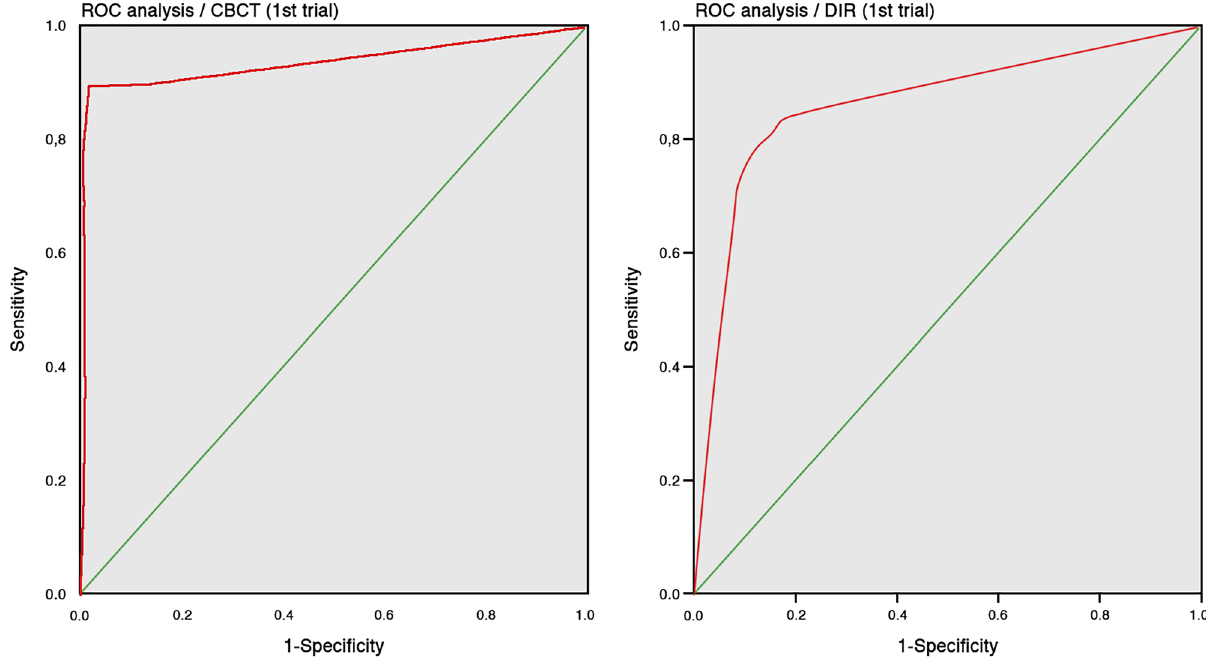
Figure 5. ROC analysis: CBCT (left) and DIR (right) of the first trial being the16 observers pooled with both image acquisition methods.